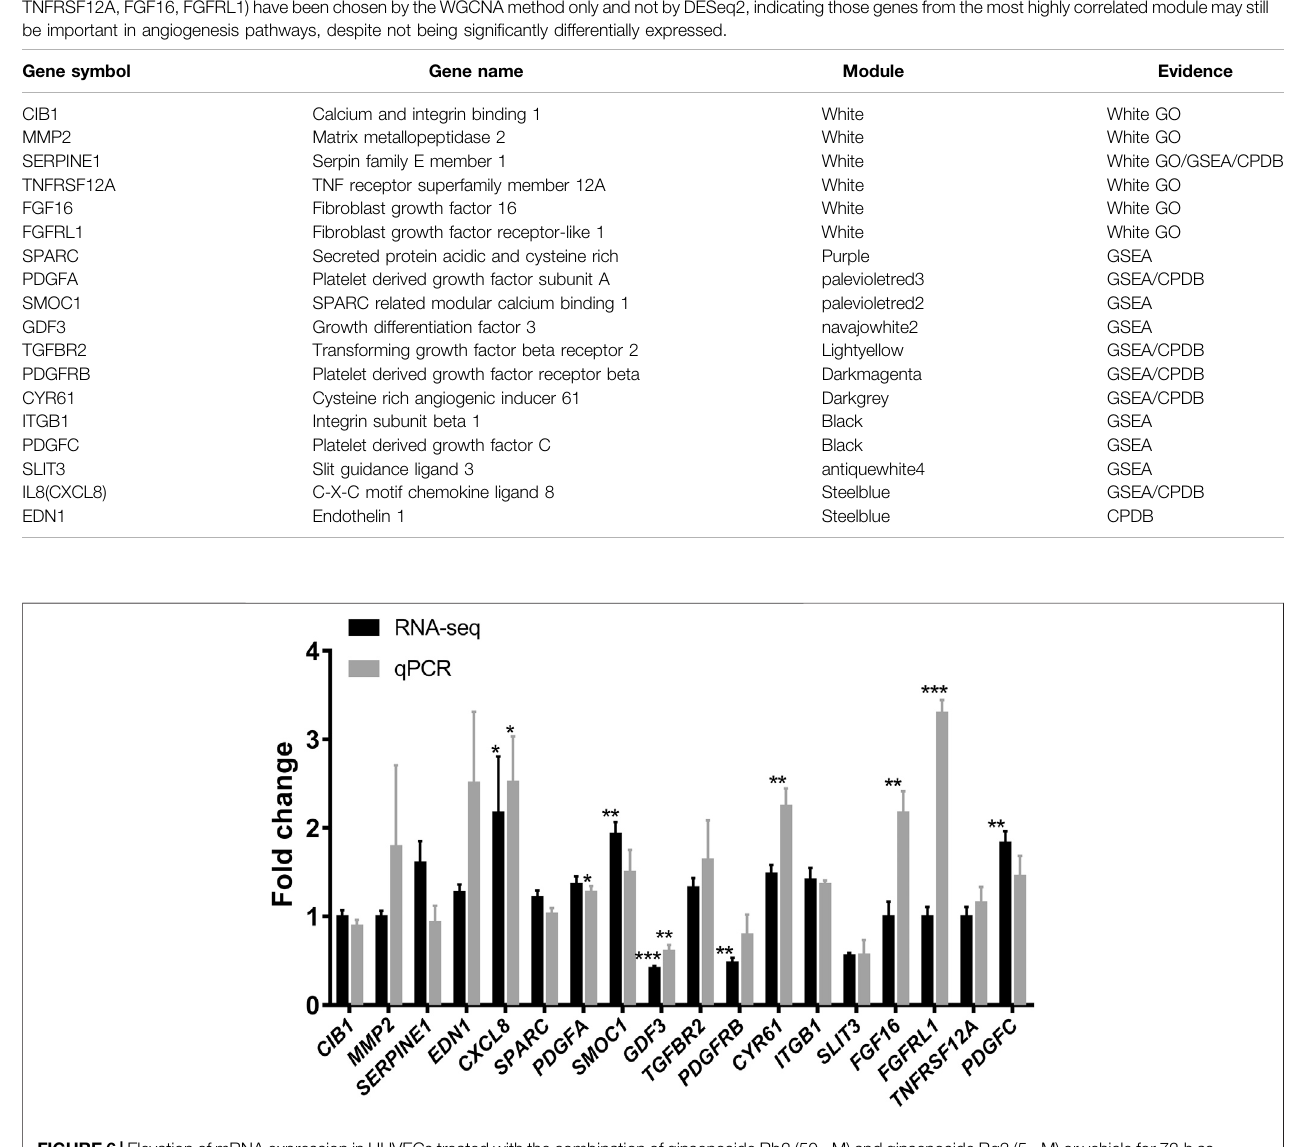
Frontiers in Pharmacology |